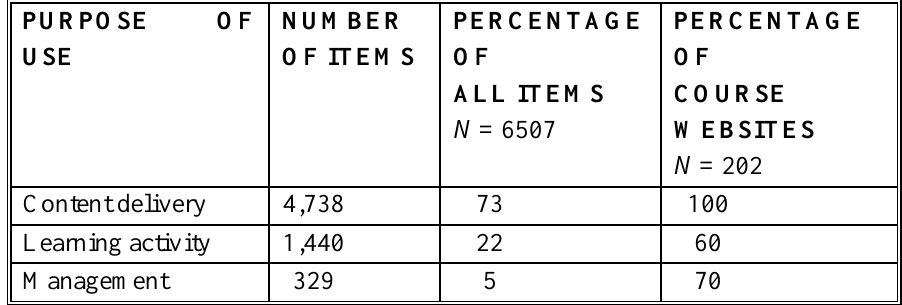
Purpose and Extent of Web Usage (N = 202 Course Web Sites /N = 6,507